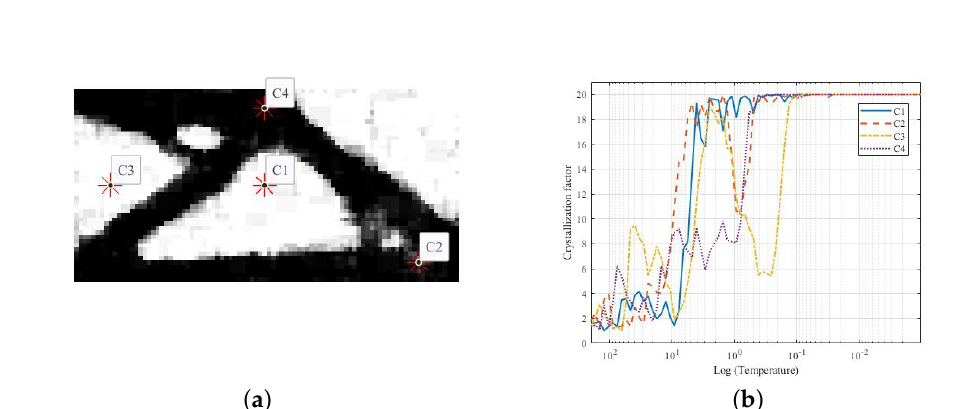
Figure 5. ( a ) Four arbitrary variables in the design domain of the cantilever beam were selected. ( b ) The average crystallization factor for each of these variables per temperature is plotted.